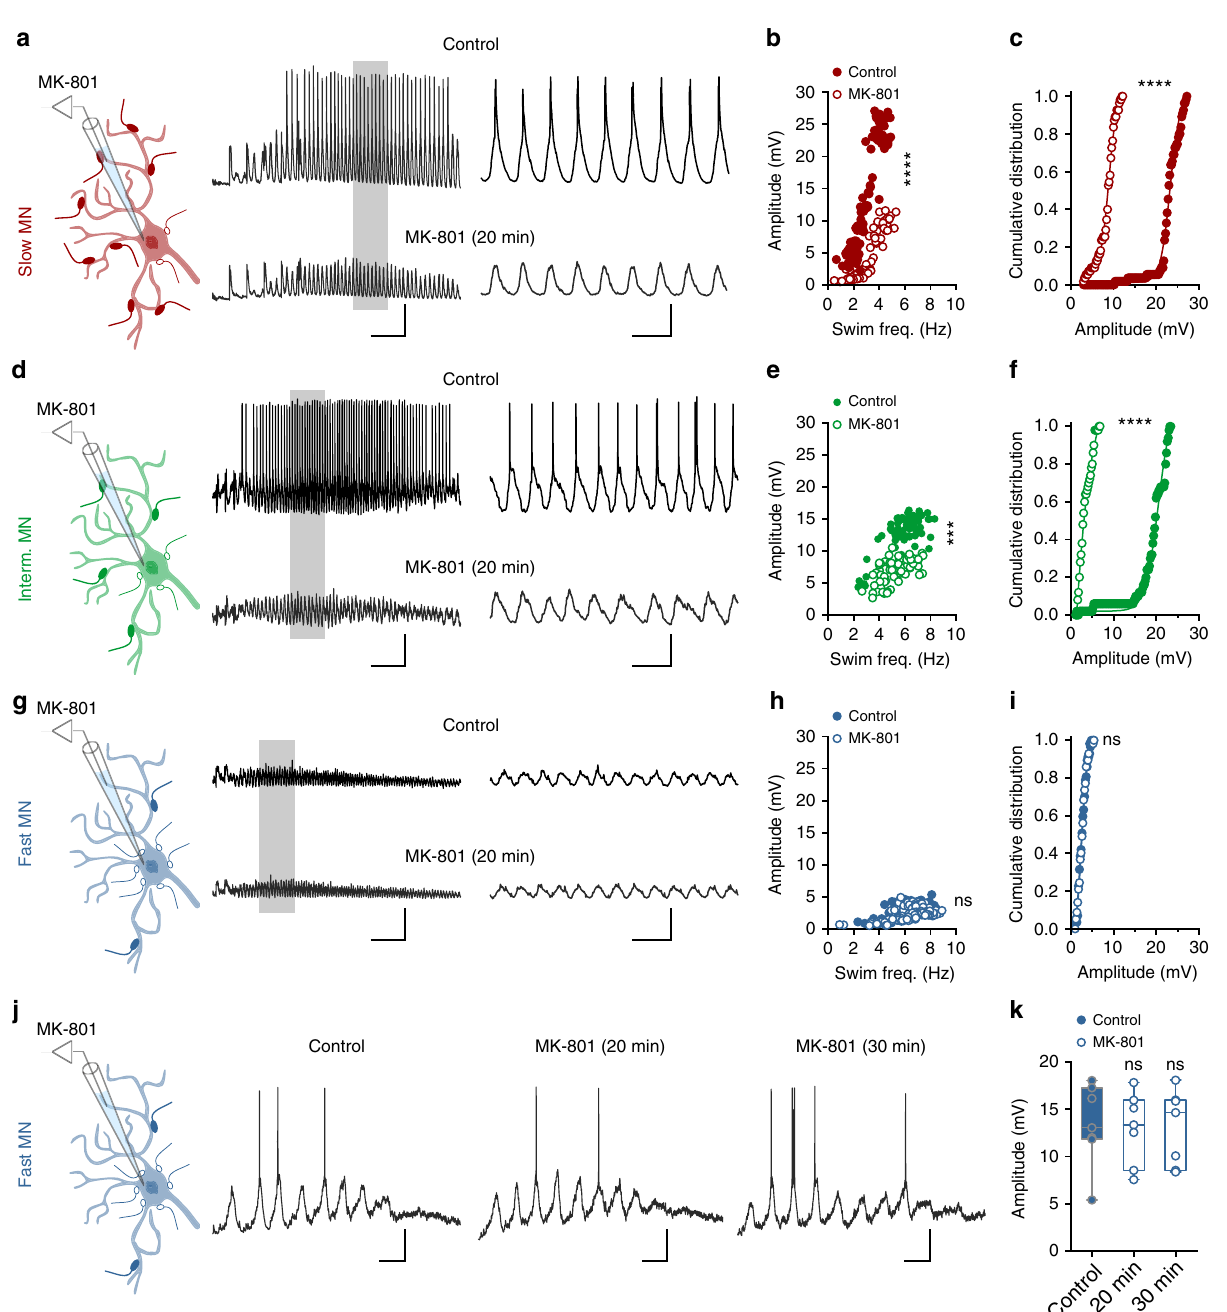
Fig. 6 NMDA-dependent mode of integration determines motoneuron recruitment order. a Selective blockade of NMDA receptors in a slow motoneuron by the intracellular dialysis of MK-801 suppressed the recruitment of these motoneuron during locomotion. b , c The amplitude of the rhythmic depolarization underlying locomotion in slow motoneurons was decreased by MK-801 ( n = 8 motoneurons from 8 separate animals; **** P < 0.0001; two- tailed Student t -test for graph in b and Kolmogorov – Smirnov test for graph in c ). d Selective blockade of NMDA receptors in intermediate motoneurons prevented the recruitment of these motoneurons during locomotion. e , f MK-801 decreased the amplitude of the depolarization in intermediate motoneurons ( n = 8 motoneurons from 8 separate animals; **** P < 0.0001; *** P < 0.001; two-tailed Student t -test for graph in e and Kolmogorov – Smirnov test for graph in f ). g In fast motoneurons, blockade of NMDA receptors by MK-801 had no effect on the amplitude of their subthreshold rhythmic drive. h , i There was no change in the amplitude of the depolarization in fast motoneurons ( n = 8 motoneurons from 8 separate animals; P > 0.05; two-tailed Student t -test for graph in h and Kolmogorov – Smirnov test for graph in i ). j , k Similarly, MK-801 had no effect on the fi ring of fast motoneurons during locomotion ( n = 6 motoneurons from 6 separate animals; P > 0.05; two-tailed Student t -test; the boxes are bound by the 25th and 75th percentiles, whiskers extend from min. to max.). Scale bars, 2 s, 400 ms, 10 mV a – g , 100 ms, 10 mV